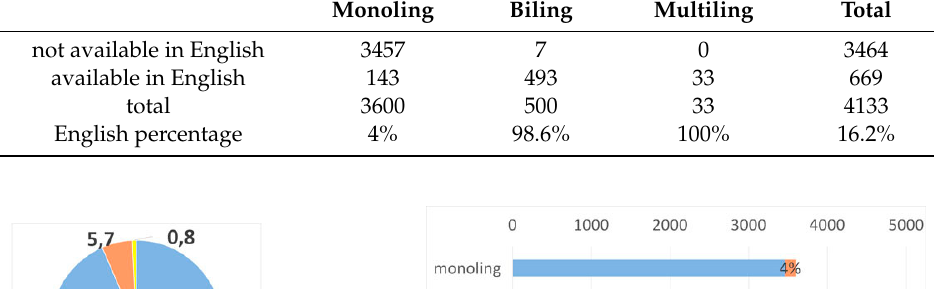
Figure A21. Visualization of the results for domain pl. ( a ) Primary languages pie chart and ( b ) English language availability bar chart.